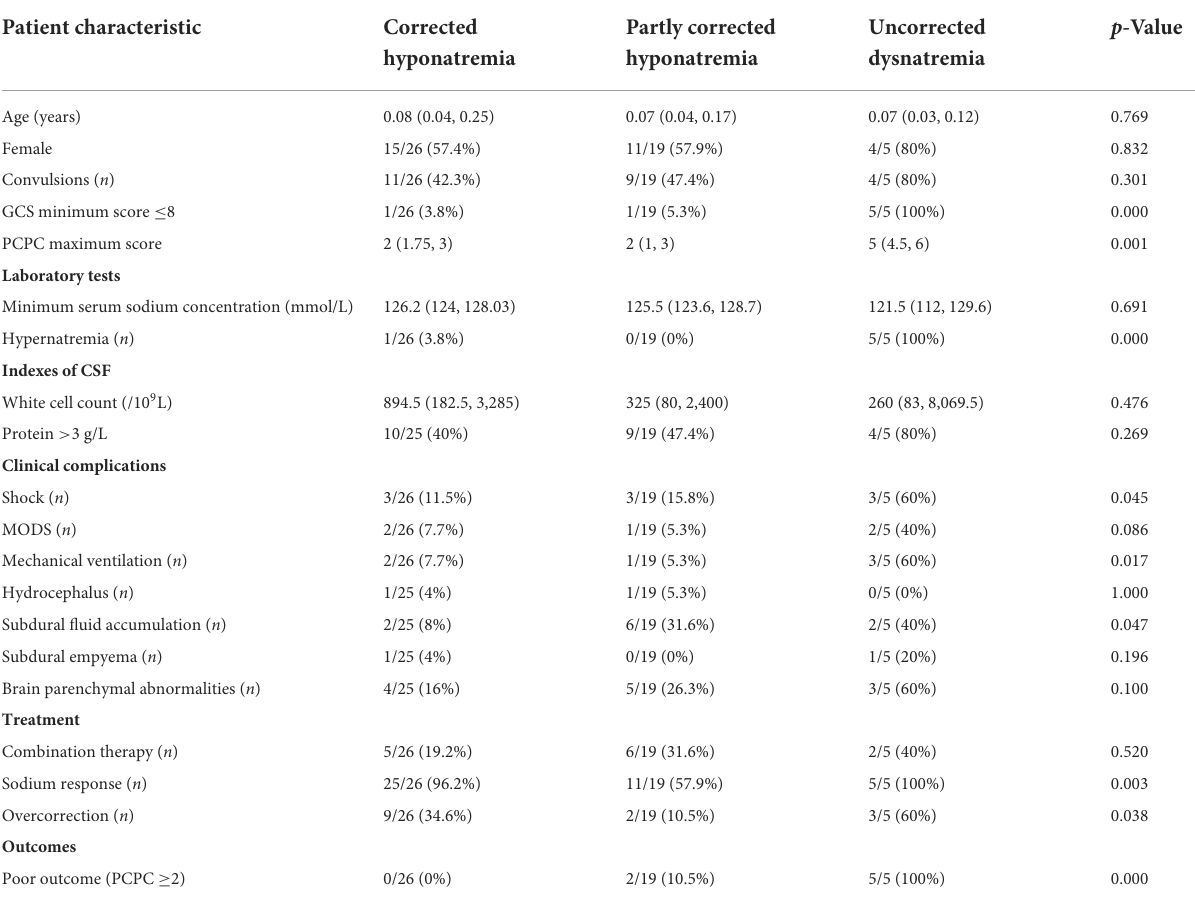
TABLE 4 Comparison of characteristics of bacterial meningitis patients with corrected hypernatremia, partly corrected hypernatremia, and uncorrected